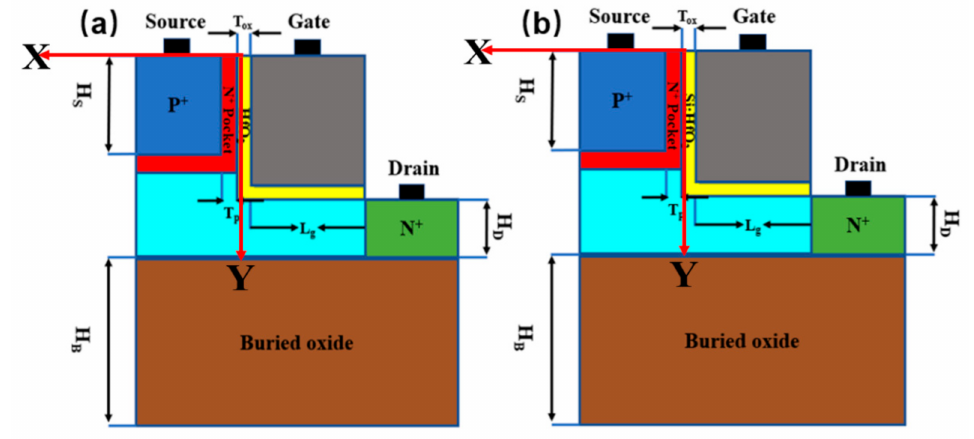
Figure 1. ( a ) The cross-section view of LTFET and ( b )